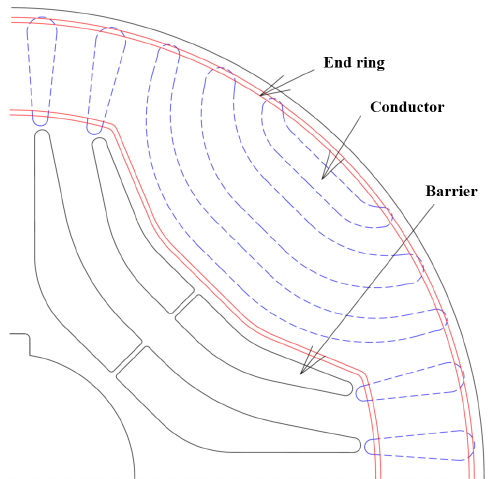
Figure 6. Rotor geometry of the first